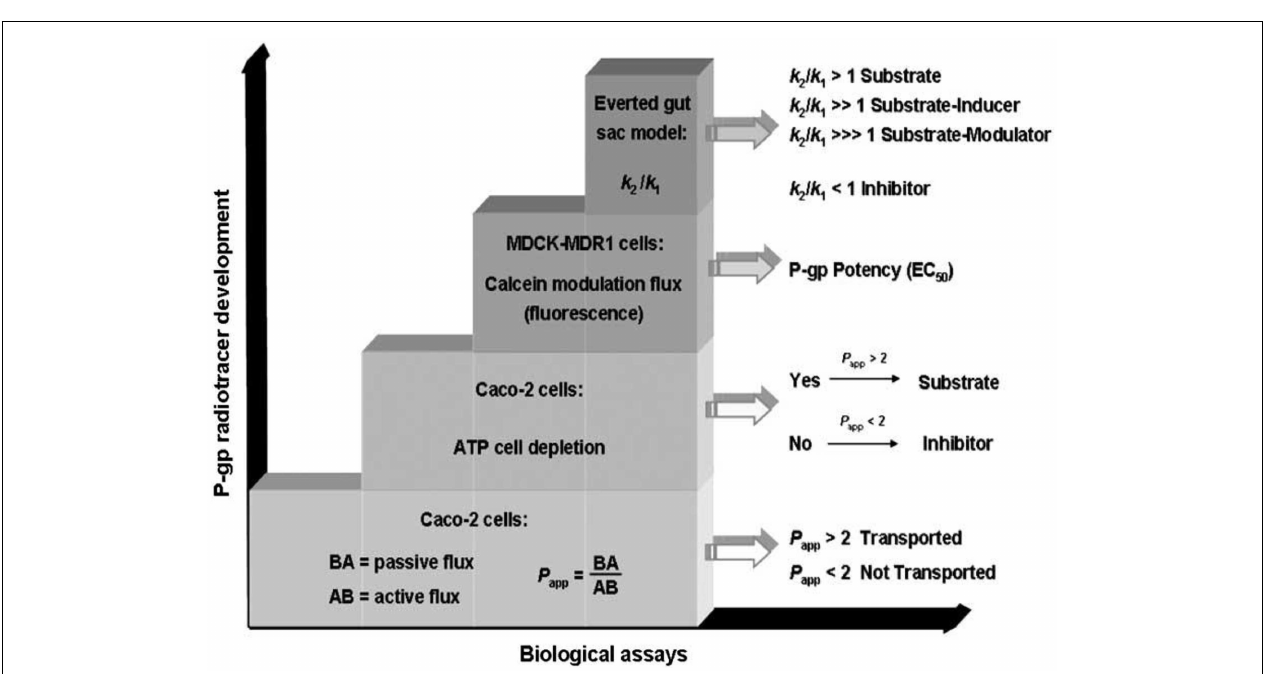
FIGURE 5 | Characterization of P-gp ligands (k 1 : influx constant; k 2 : efflux constant) . Picture reported in Ref. (16).